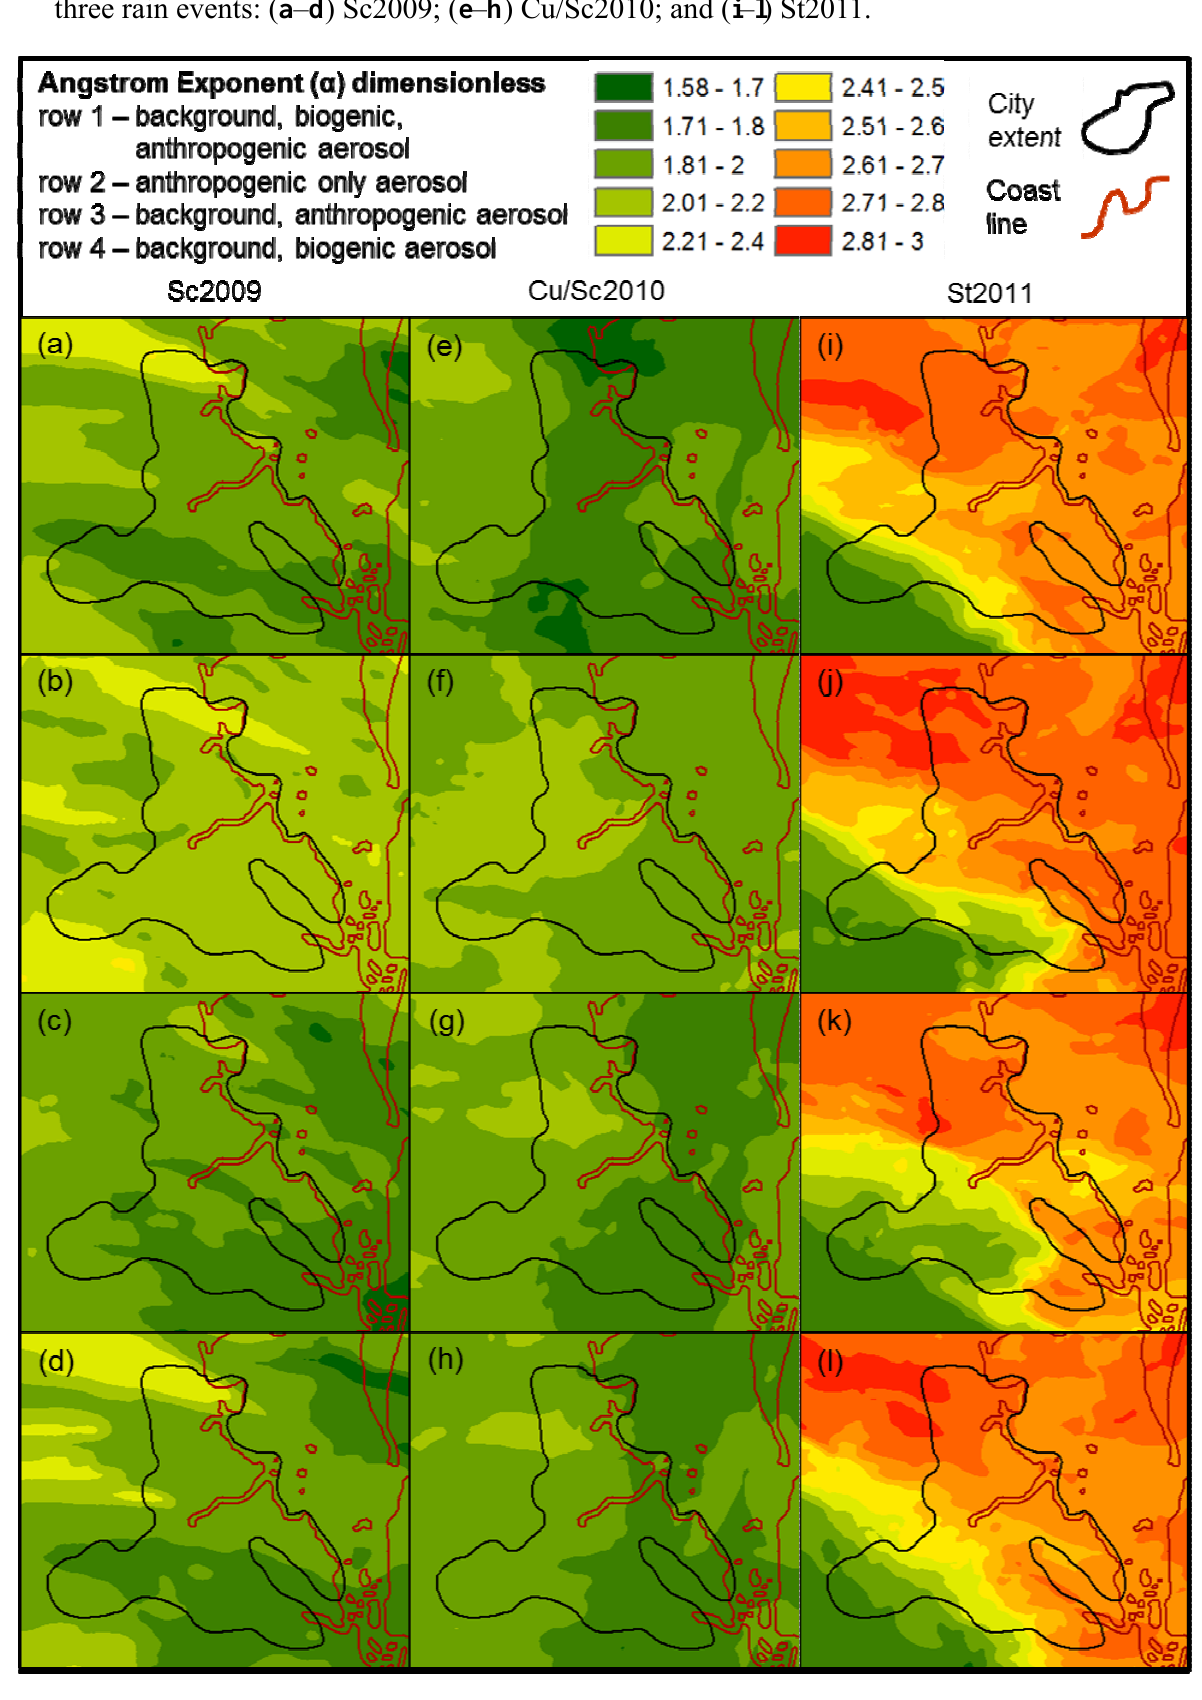
Figure 6. WRF Angstrom exponent for four aerosol transport scheme configurations and three rain events: ( a – d ) Sc2009; ( e – h ) Cu/Sc2010; and ( i – l )